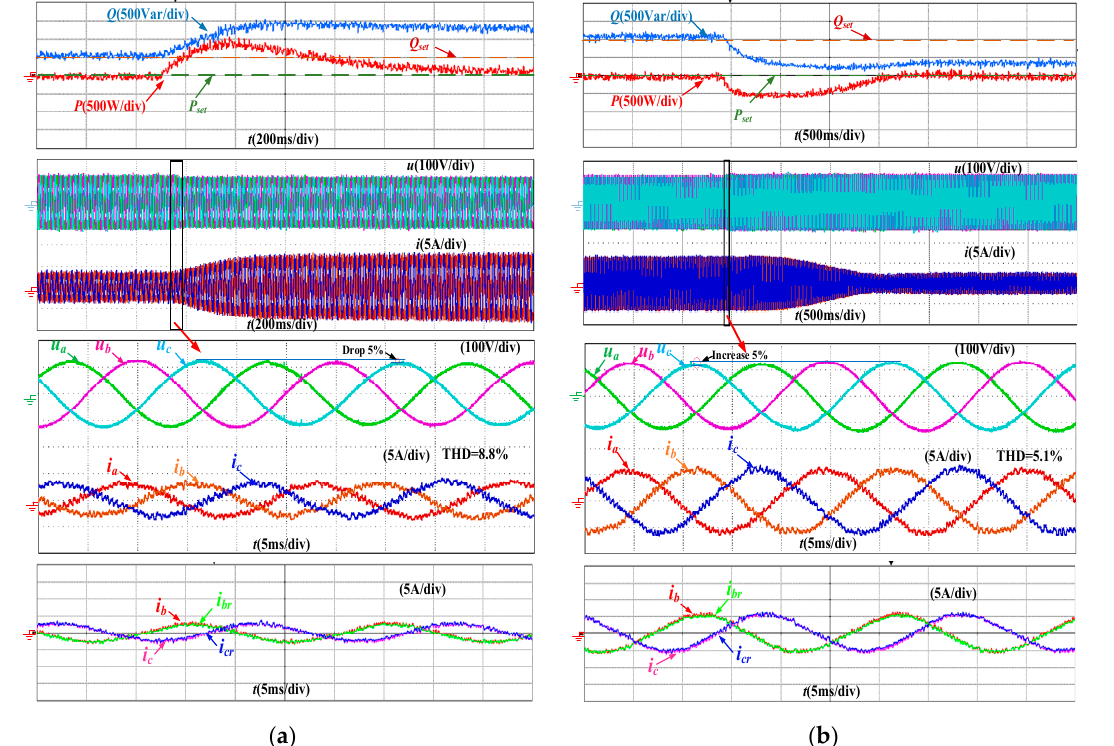
Figure 13. Experimental waveform of reactive power with voltage regulation (from top to bottom: reference and actual active power P set , P , reference and actual reactive power Q set , Q ; grid voltage u a , u b , u c , grid current i a , i b , i c ; reconstructed and actual current of phases B and C i br , i cr , i b , i c ): ( a ) the grid voltage drops by 5%; ( b ) the grid voltage increases by 5%.